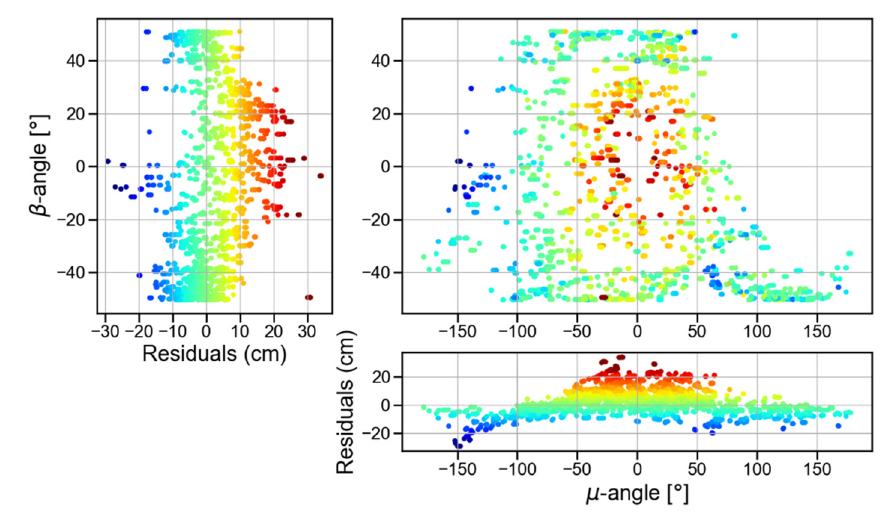
Figure 4. SLR residuals distributed with respect to β and μ for the C13 ABW orbit